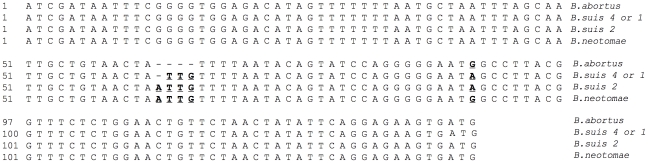
Multiple alignment of nucleotide sequences of the 5′ flanking region of sodC start codon from B. abortus, B. suis biovars 4 (strain 40) or 1 (strain 1330) and 2 (strain Thomsen), and B. neotomae.Alignment was performed with the Clustal method of the MegAlign program of LaserGene software. Gaps are indicated by dashes. The nucleotides differing between B. suis and B. abortus or B. neotomae are in bold and underlined. Note: B. melitensis nucleotide sequences are identical to those of B. abortus shown above.